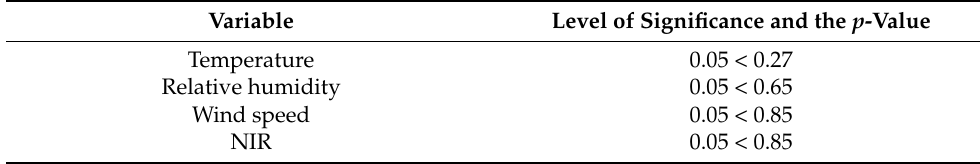
Table 5. Comparison between the level of significance and the p-value.